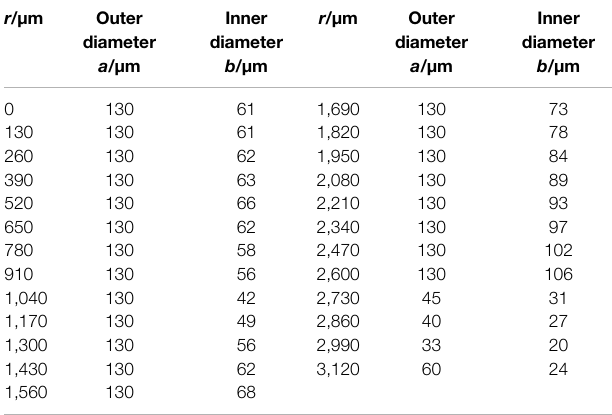
TABLE 1 | The parameters of the selected structures and the corresponding position on the meta-lens. r /µm Outer